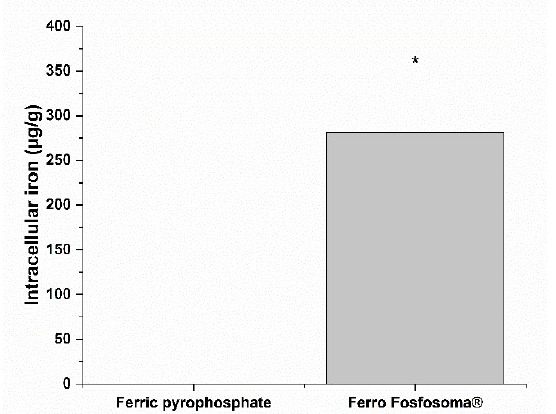
Figure 2. Intracellular Fe concentrations ( µ g/g cellular protein) in intestinal epithelial cell (Caco-2) monolayer at the end of the 3 h incubation with bioaccessible fractions of the two Fe formulations. * p <